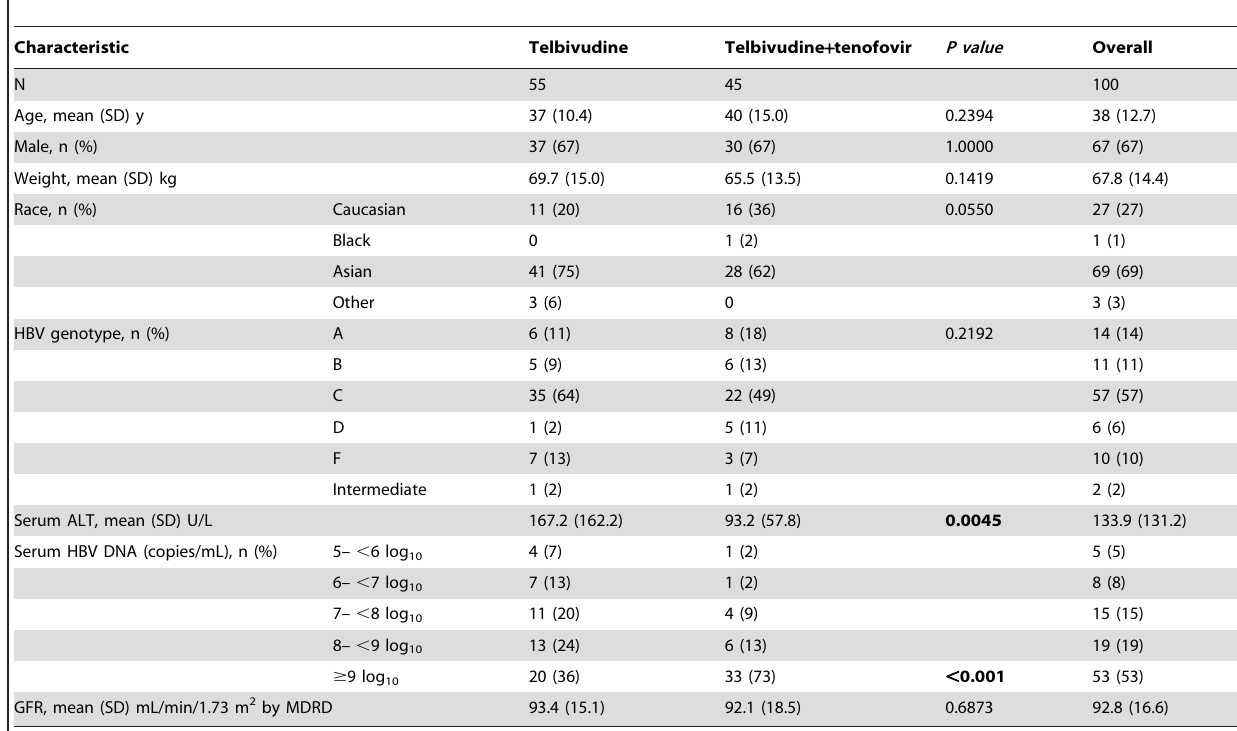
Table 1. Demographics and baseline characteristics (efficacy population) according to post-Week 24